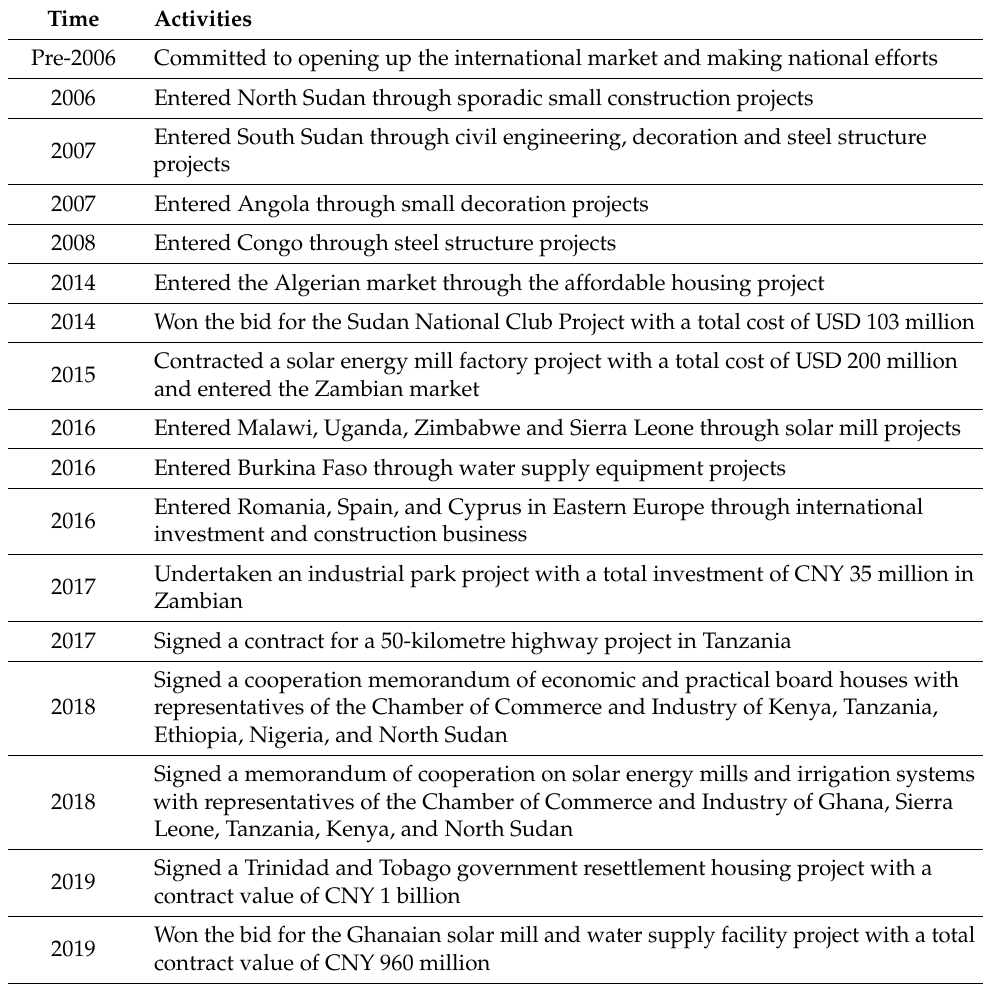
Table 3. Significant international activities of the case